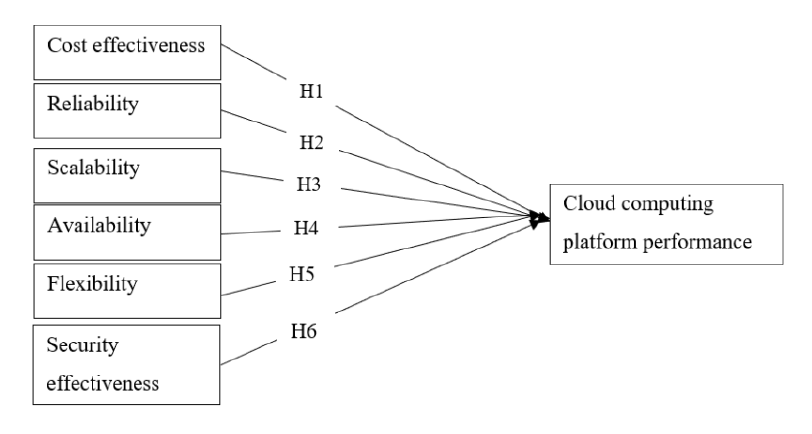
Figure 1: Conceptual Model of the Study; Source: